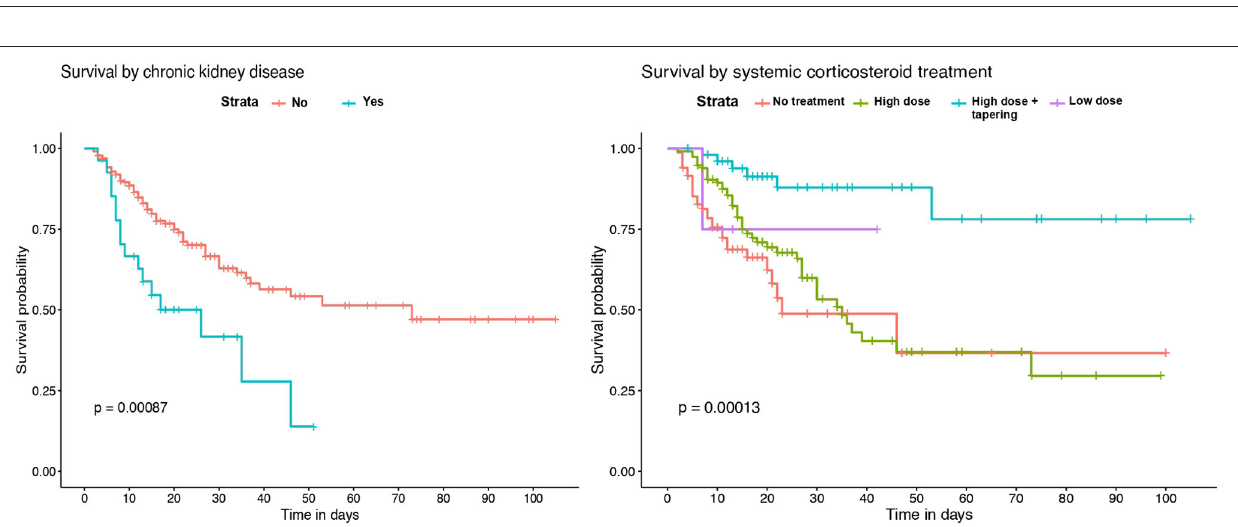
FIGURE 2 | Kaplan–Meier survival analysis by age and previous chronic respiratory conditions.